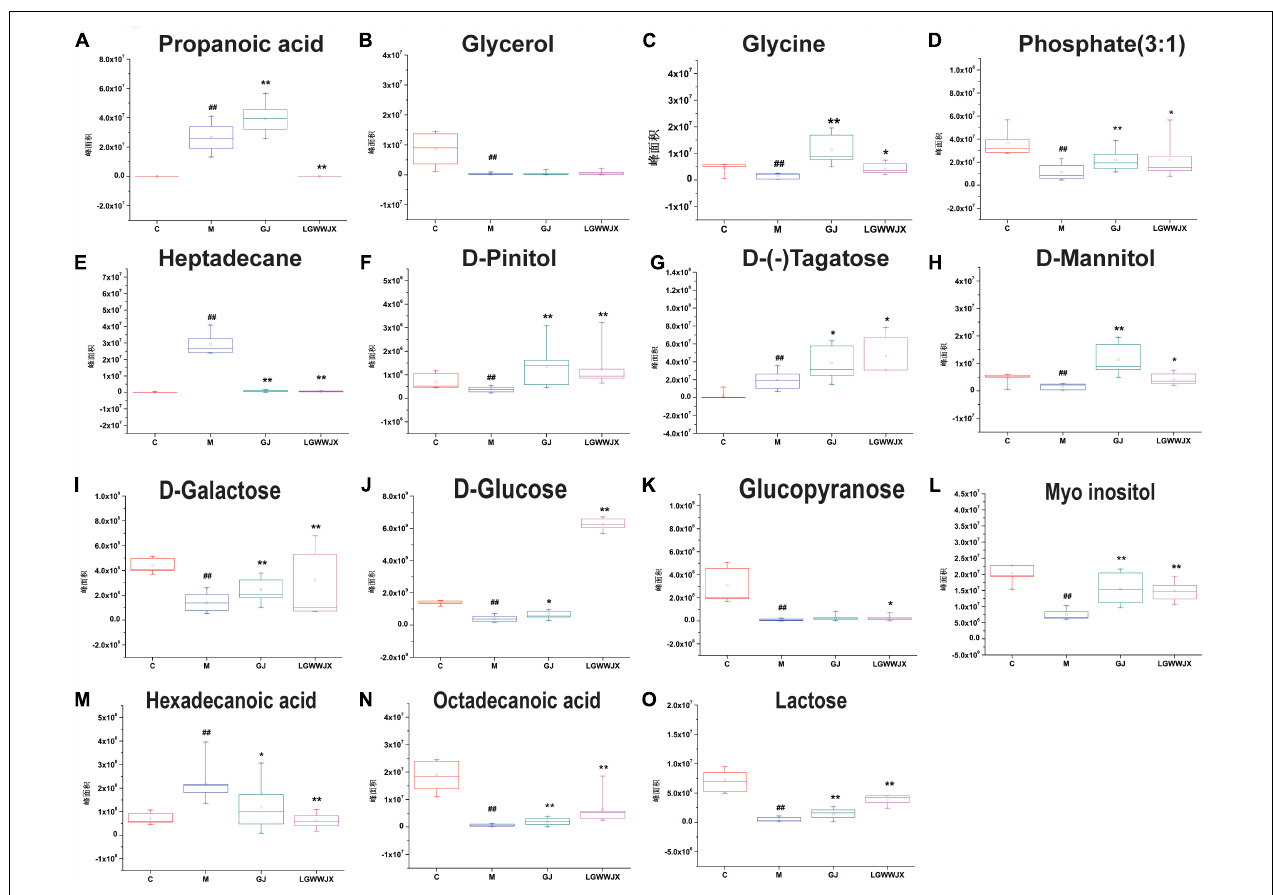
FIGURE 5 | Expression levels of differentially expressed metabolites in serum. (A) Propanoic acid; (B) Glycerol; (C) Glycine; (D) Phosphate (3:1); (E) Heptadecane; (F) D -Pinitol; (G) D -(–)Tagatose; (H) D -Mannitol; (I) D -Galactose; (J) D -Glucose; (K) Glucopyranose; (L) Myoinositol; (M) Hexadecanoic acid; (N) Octadecanoic acid; (O) Lactose. C, control group; M, model group; GJ, GanJiang decoction group; LGWWJX, LGWWJX decoction group. # p < 0.05, ## p < 0.01, compared with the control group. ∗ p < 0.05, ∗∗ p < 0.01, compared with the model group.